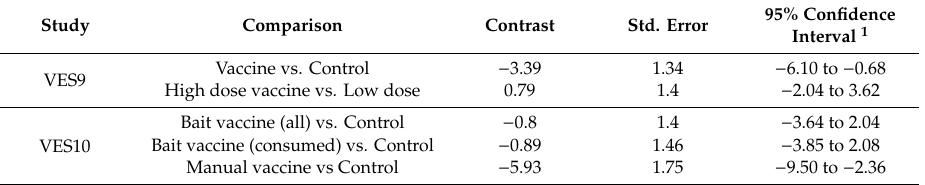
Table 5. Planned comparisons of Disease Burden Score (DBS) between